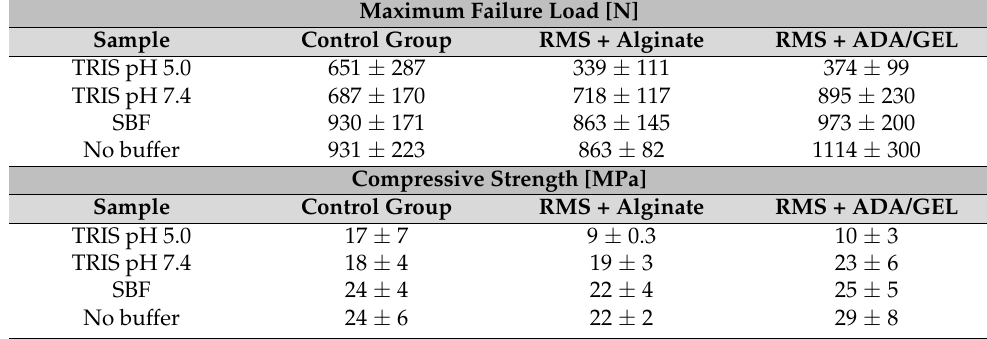
Table 7. Maximum Failure Load and Compressive Strength of the